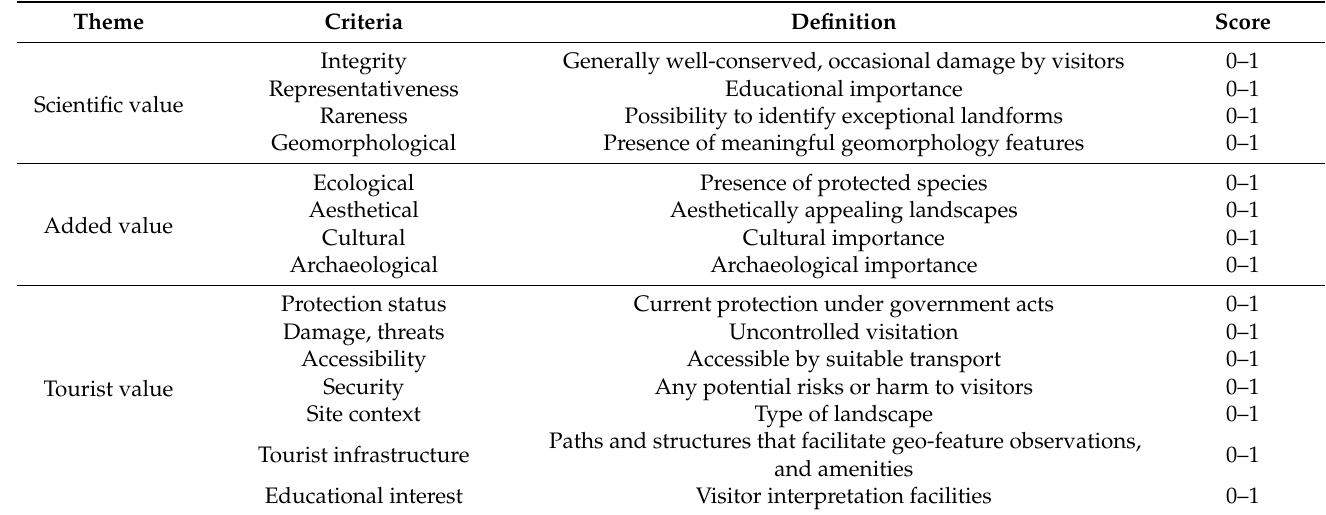
Table 2. Criteria used for the quantitative assessment of the geotourism potential of four sites in Yala National Park, Sri Lanka.